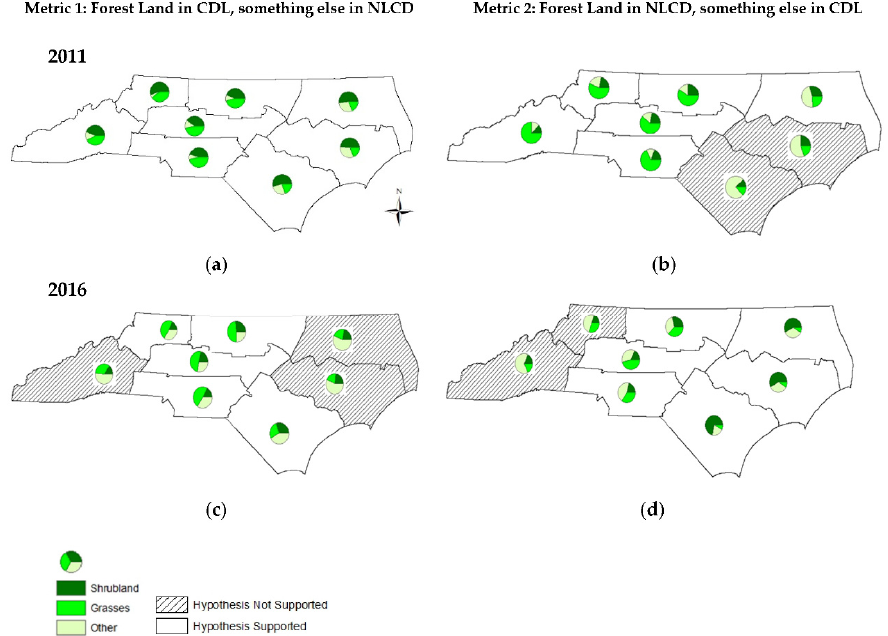
Figure 4. ( a – d ) Mismatched forestland in 2011 and 2016. Pie charts show the composition of the absolute mismatch, and shaded areas show the ASDs that do not support Hypothesis 2.1 .